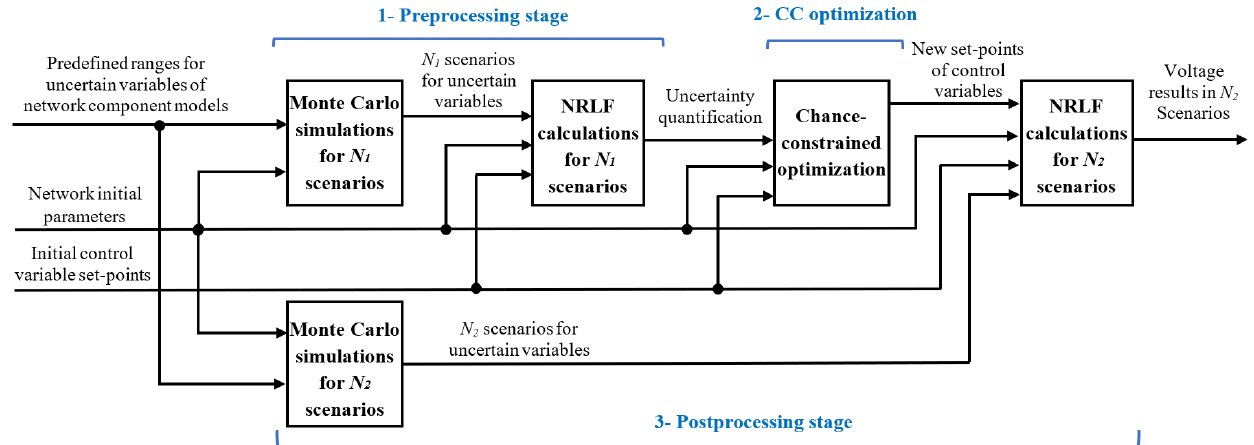
Figure 1. Proposed chance-constrained voltage control framework.